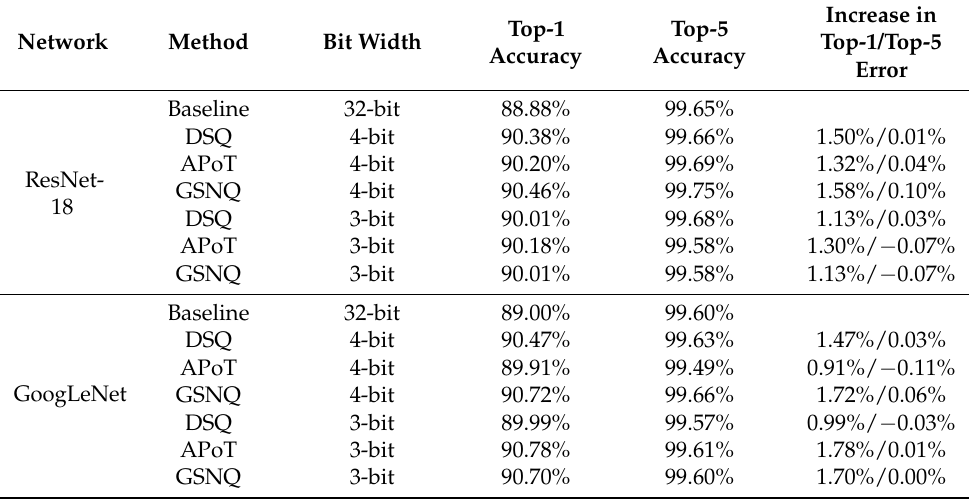
Table 9. Comparison with the state-of-the-art quantization methods on